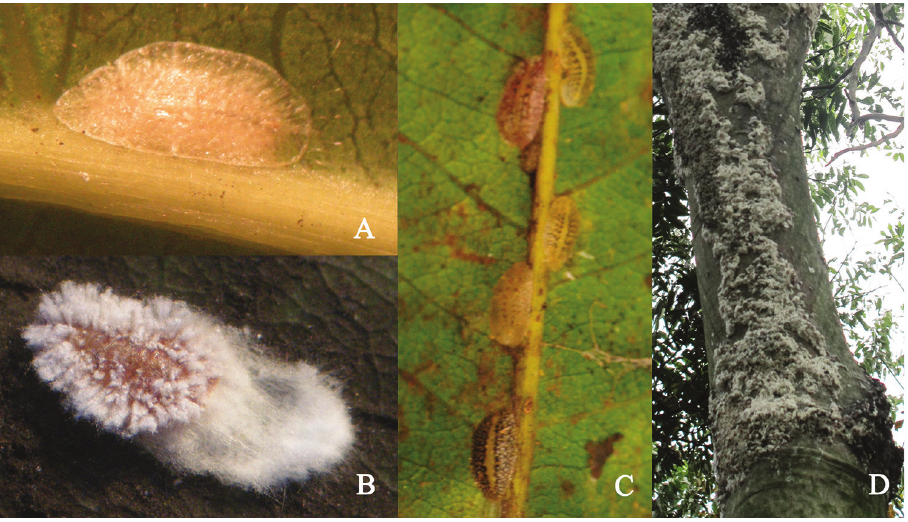
Figure 1. Leptopulvinaria sapinda sp. n., A young adult female B adult female after oviposition C adult females from young to mature stages D ovisacs on trunk of host